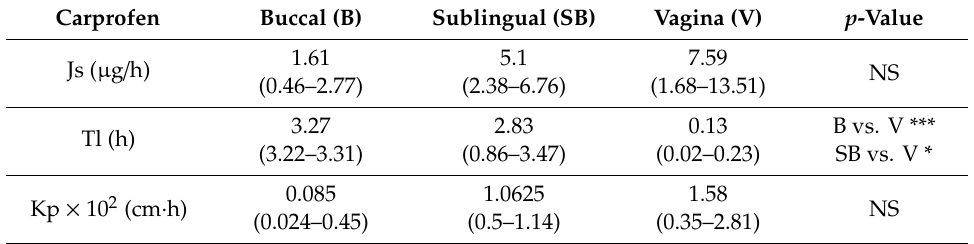
Table 3. Median, maximum and minimum values of flux (Js), lag time (Tl) and permeability coe ffi cient (Kp) of CP at 6 h from CP-Sat through mucous membranes (buccal, sublingual and